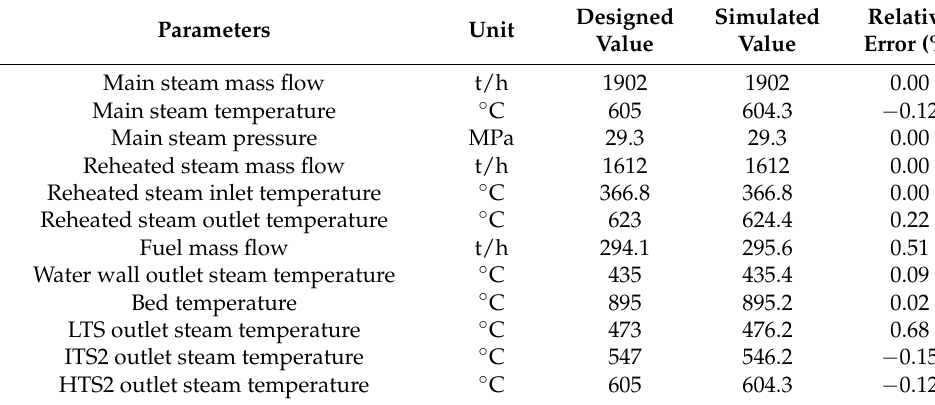
Table 1. Simulation results at 100% BMCR.